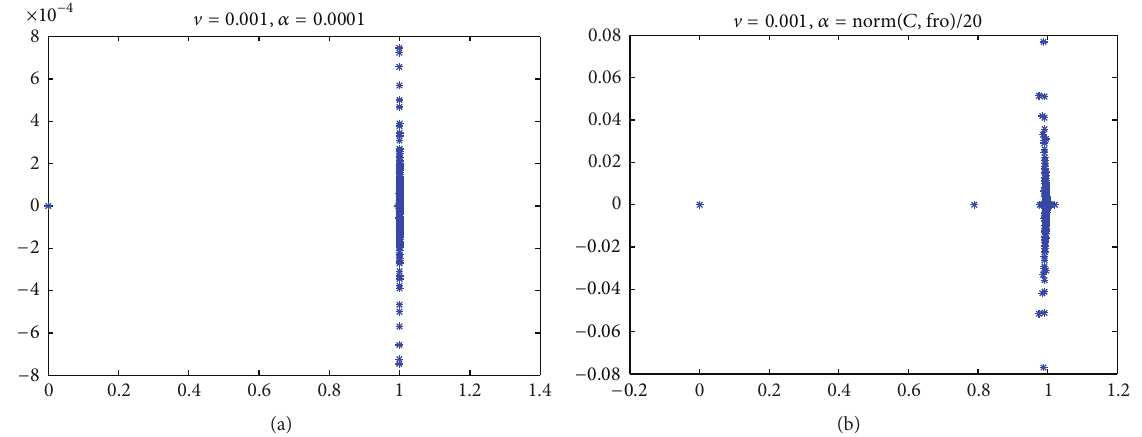
Figure 3: Spectrum of the preconditioned steady Oseen matrix with viscosity coefficient V = 0.001, 32 × 32 grid. (a) Q2-Q1 FEM, 𝐶 = 0 ; (b) Q1-P0 FEM, 𝐶 ̸=0